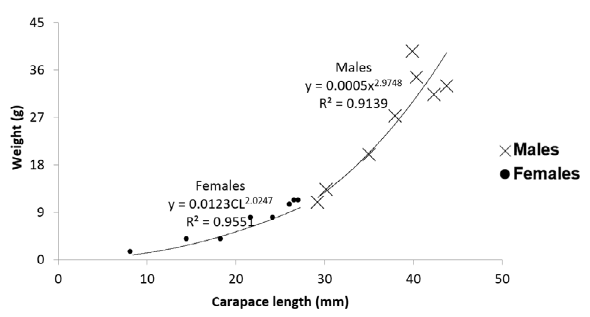
Figure 5. Relationship between carapace length and weight of Atya scabra (Leach, 1816) in the Fluvial Islands Domain in the Paraíba do Sul River